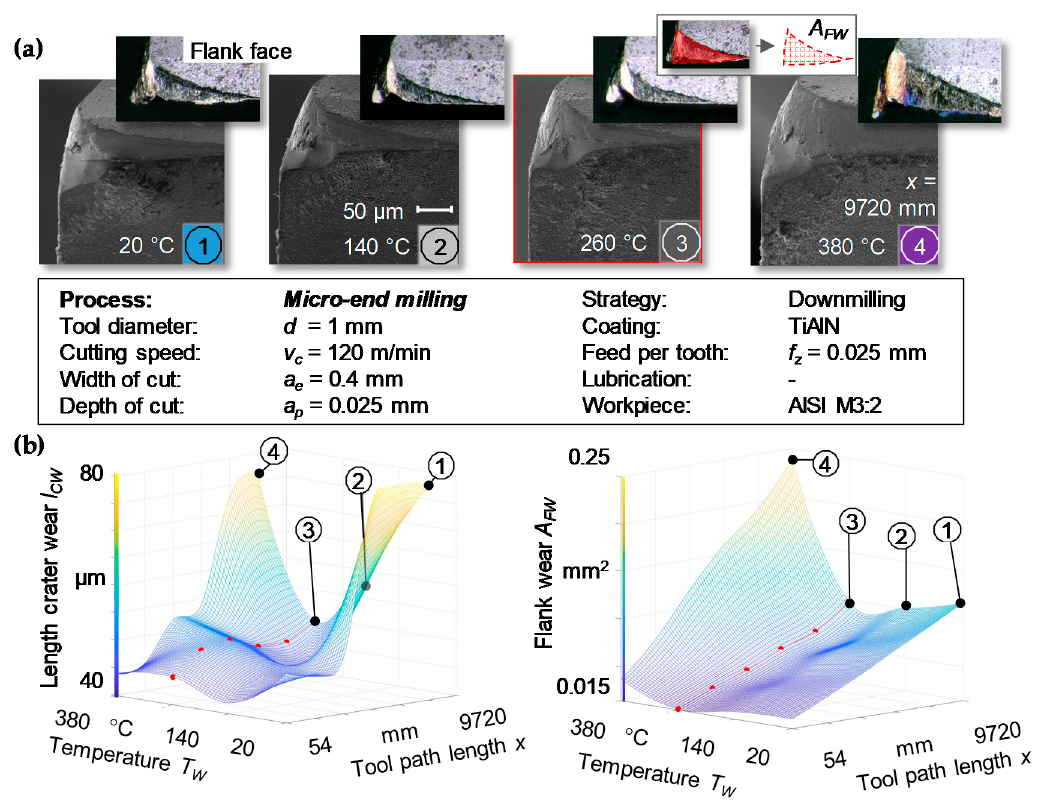
Figure 3. ( a ) SEM images to depict wear states; ( b ) diagrams of measurements of crater wear l CW ( left ) and flank wear A FW ( right ) progressions.